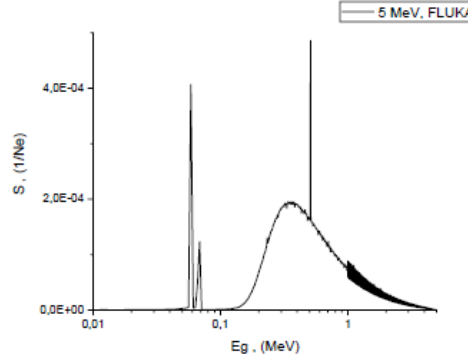
Fig. 3. The simulated braked gamma spectrum of 5 MeV electron beam in 2 mm tungsten converter. In Fig. 3 is shown a comparison of the bremsstrahlung spectra simulated for electron beam of energies 4 MeV, 5 MeV, 8 MeV, and 9 MeV [11]. It is seen that the shape of the peak is preserved, and with increasing electrons energy the yield of gamma quanta is increased. In the study of nuclear reactions, only a part of the gamma spectrum with energy greater than the reaction threshold "works". In our case of neutrons generation on a beryllium target, it is gamma quanta with energies greater than 1.6 MeV. But at a set of the absorbed dose, it is necessary to consider the whole bremsstrahlung spectrum.